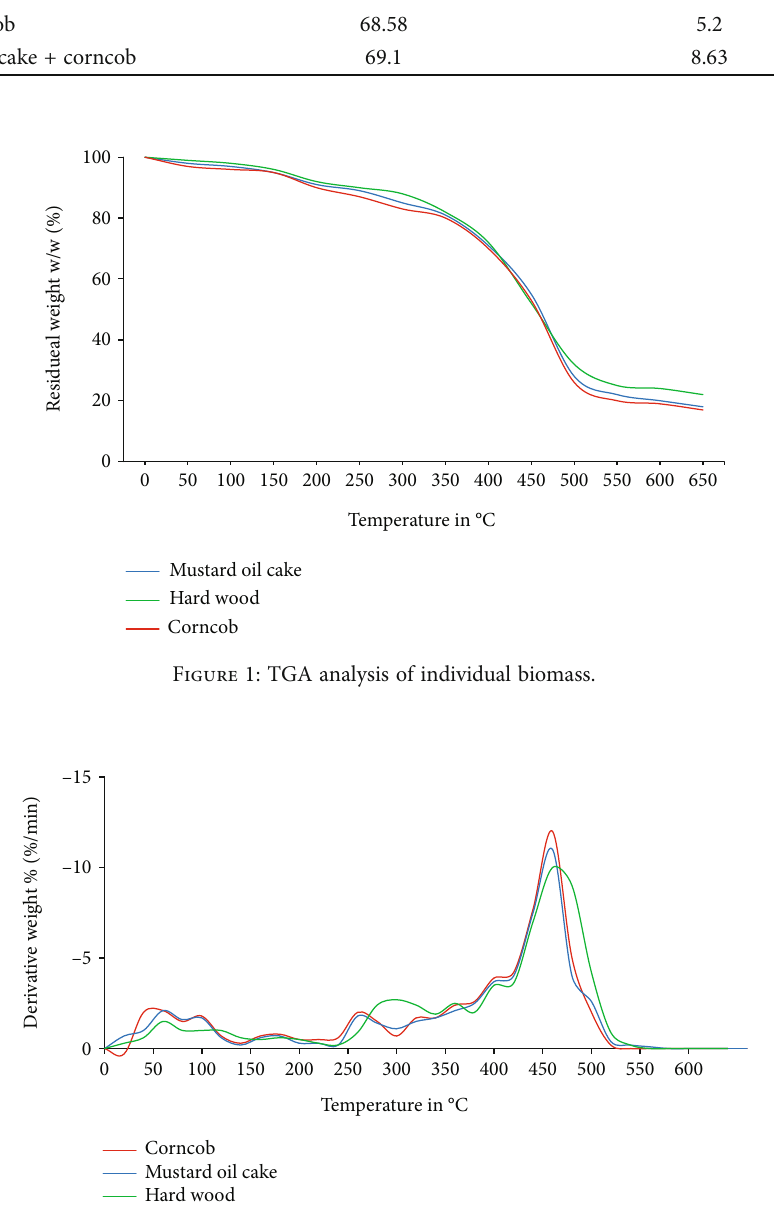
Figure 2: DTG analysis of individual